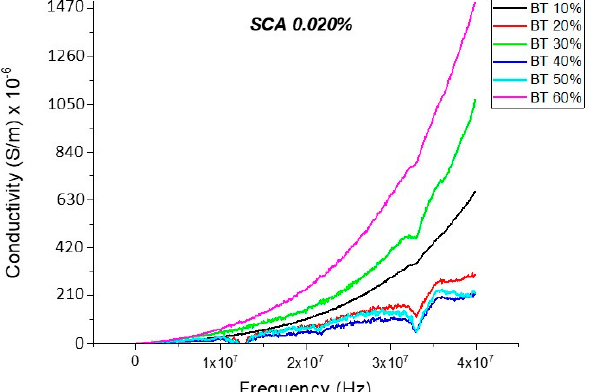
Figure 21. The conductivity of the BaTiO 3 -epoxy composite that were fabricated using BaTiO 3 nanoparticles which were surface modified using 0.015 SCA is plotted as a function of frequency. The maximum value of conductivity at 20 MHz is 4.36 × 10 − 4 S/m and occurs at BT 0.6.